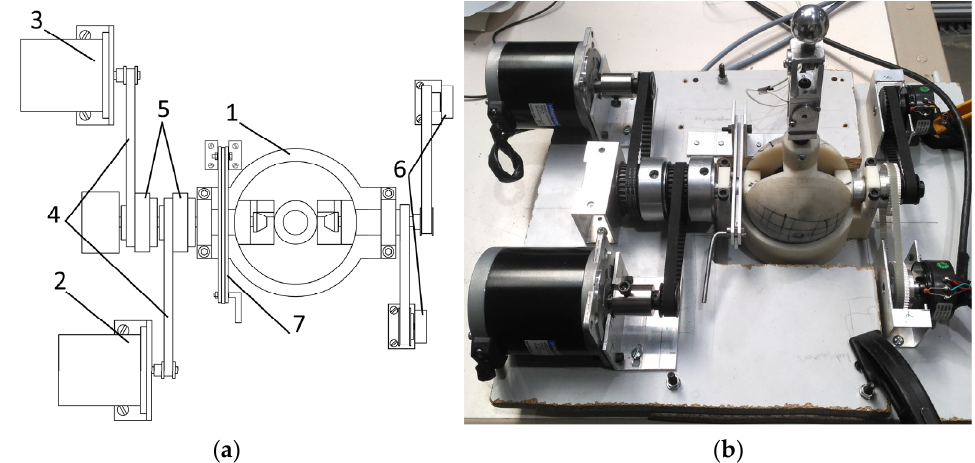
Figure 7. Haptic device with the differential gear-based joint: ( a ) schematic representation: 1 the joint, 2 and 3 actuators, 4 belt drives, 5 step-to-torque-transforming bushing, 6 rotary encoder, 7 clamping mechanism; ( b ) real setup.